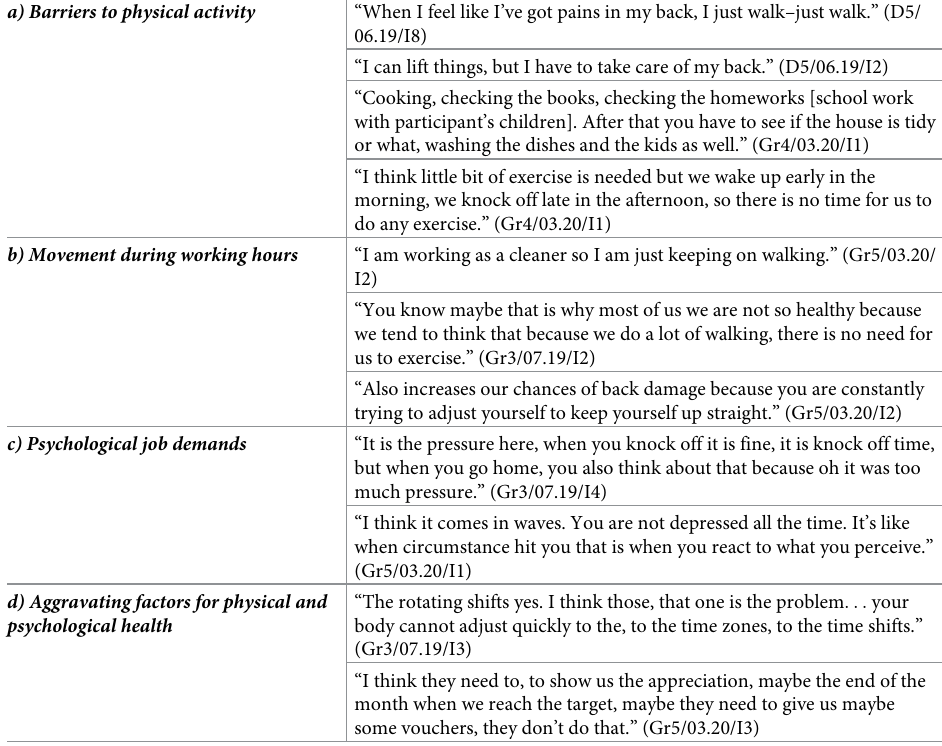
Table 2. Physical and psychological health, sub-themes and illustrative quotes. a) Barriers to physical